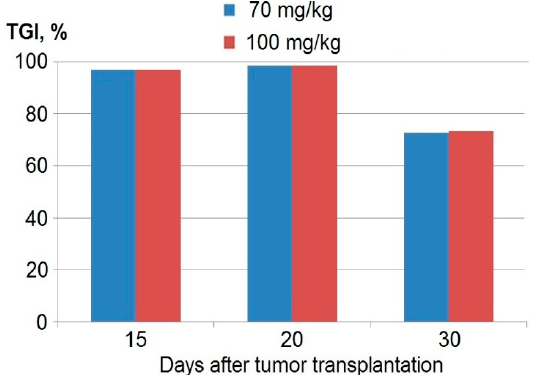
Figure 2. Tumor growth inhibition (TGI) of Ca755 mammary adenocarcinoma after oral anthrafuran treatment for 5 days.